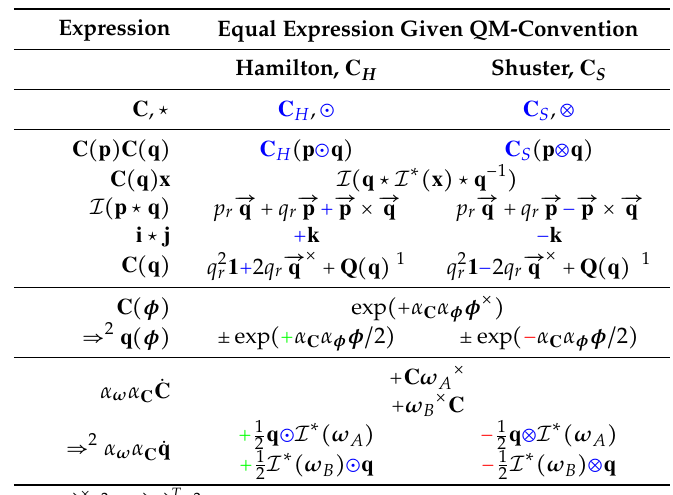
Table 2. Comparing homomorphic